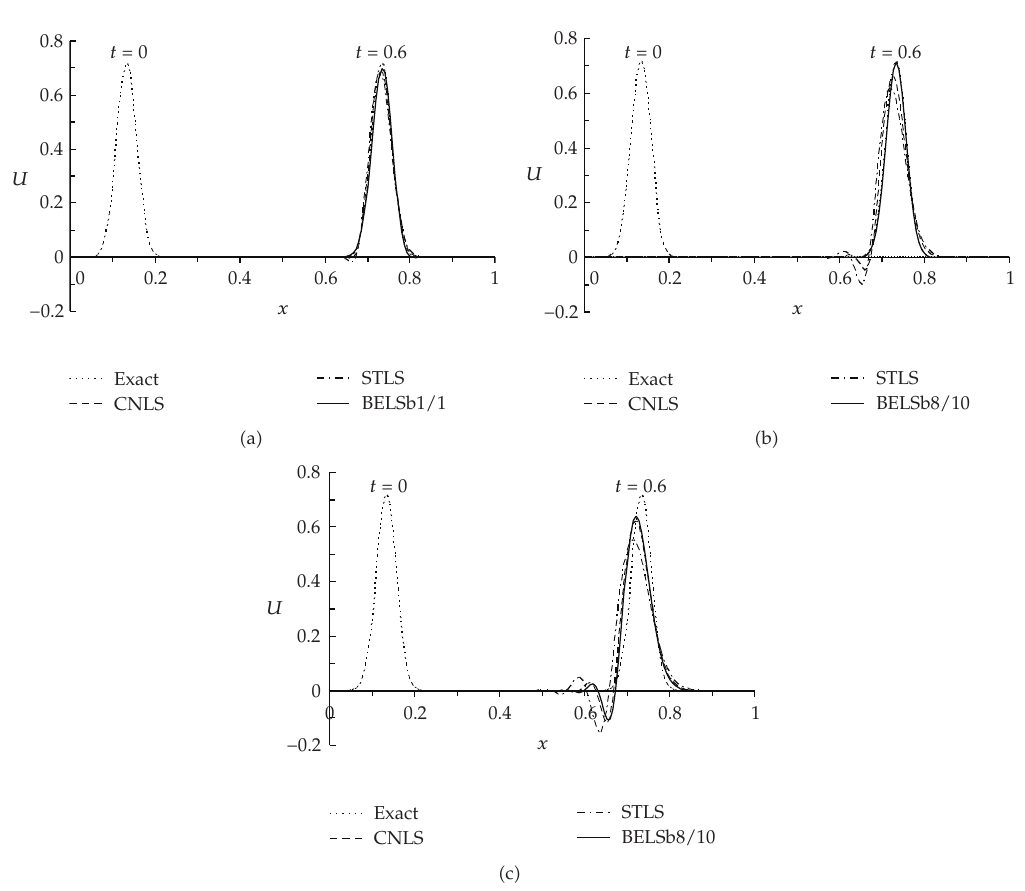
Figure 2: Propagation of Gaussian hill by time t (cid:9) 0 . 6 for Courant numbers, C (cid:9) 0 . 5 (cid:3) a (cid:4) , C (cid:9) 1 . 0 (cid:3) b (cid:4) and C (cid:9) 1 . 5 (cid:3) c (cid:4) for continuous